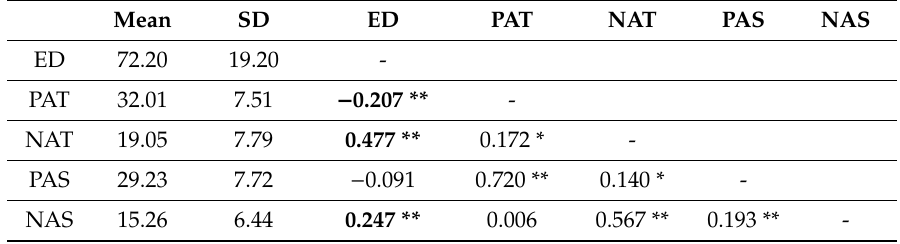
Table 6. Pearson correlations of ED / PANAS Trait and ED / PANAS